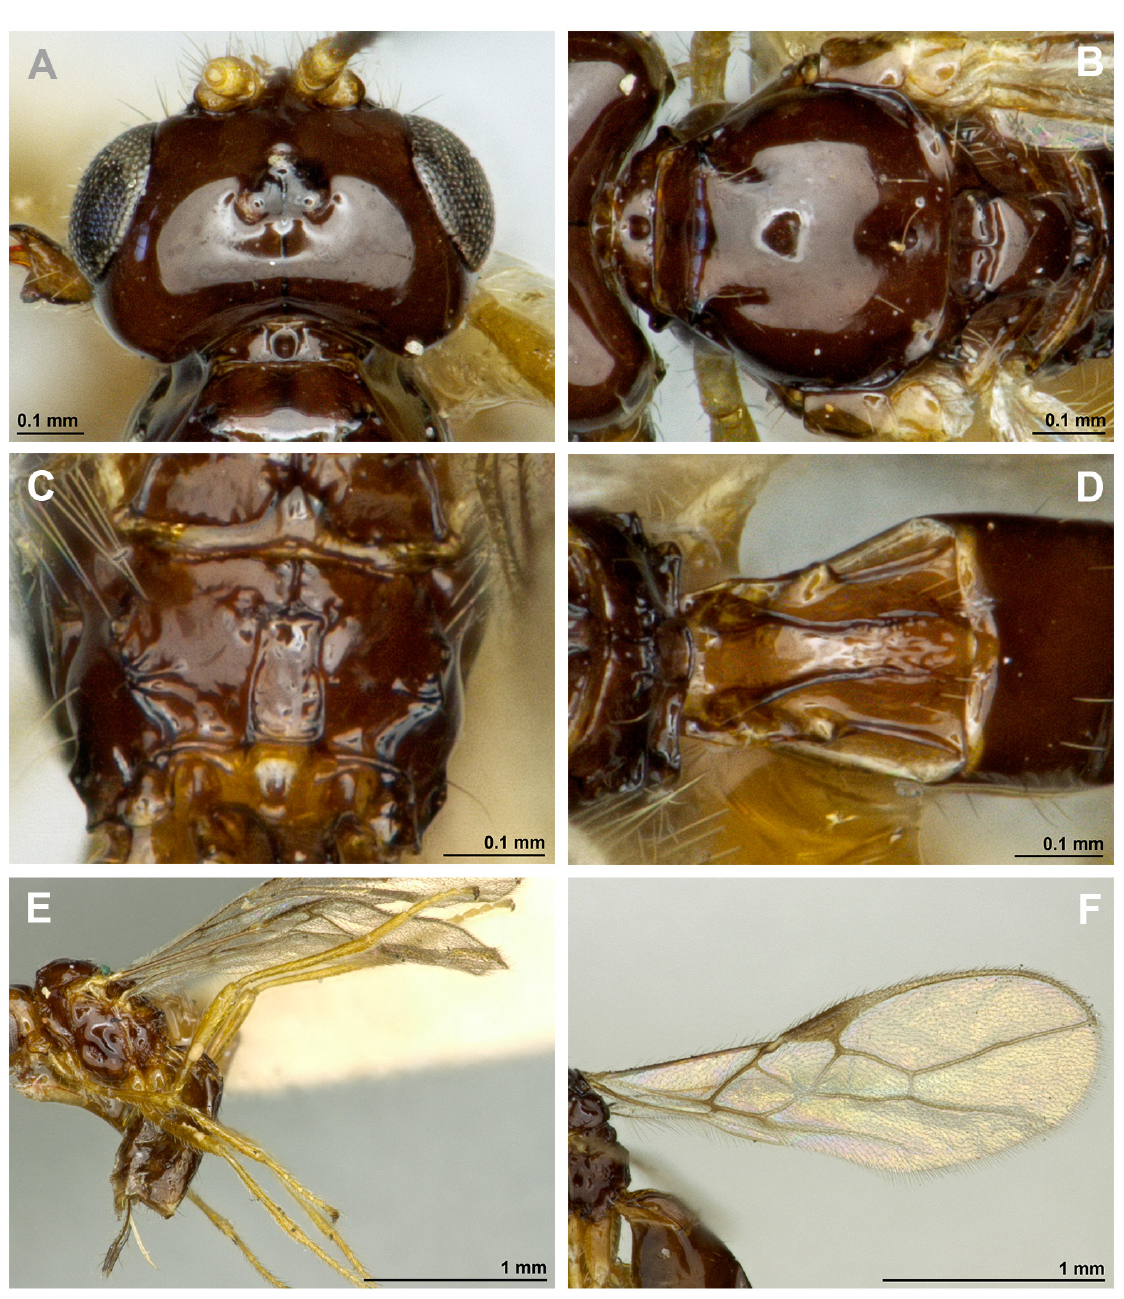
Fig. 63. Asobara taylori Peris-Felipo, sp. nov., ♀, holotype (BMNH). A . Head, dorsal view. B . Mesoscutum, dorsal view. C . Propodeum. D . First metasomal tergite, dorsal view. E . Hind leg, metasoma and ovipositor, lateral view. F . Fore